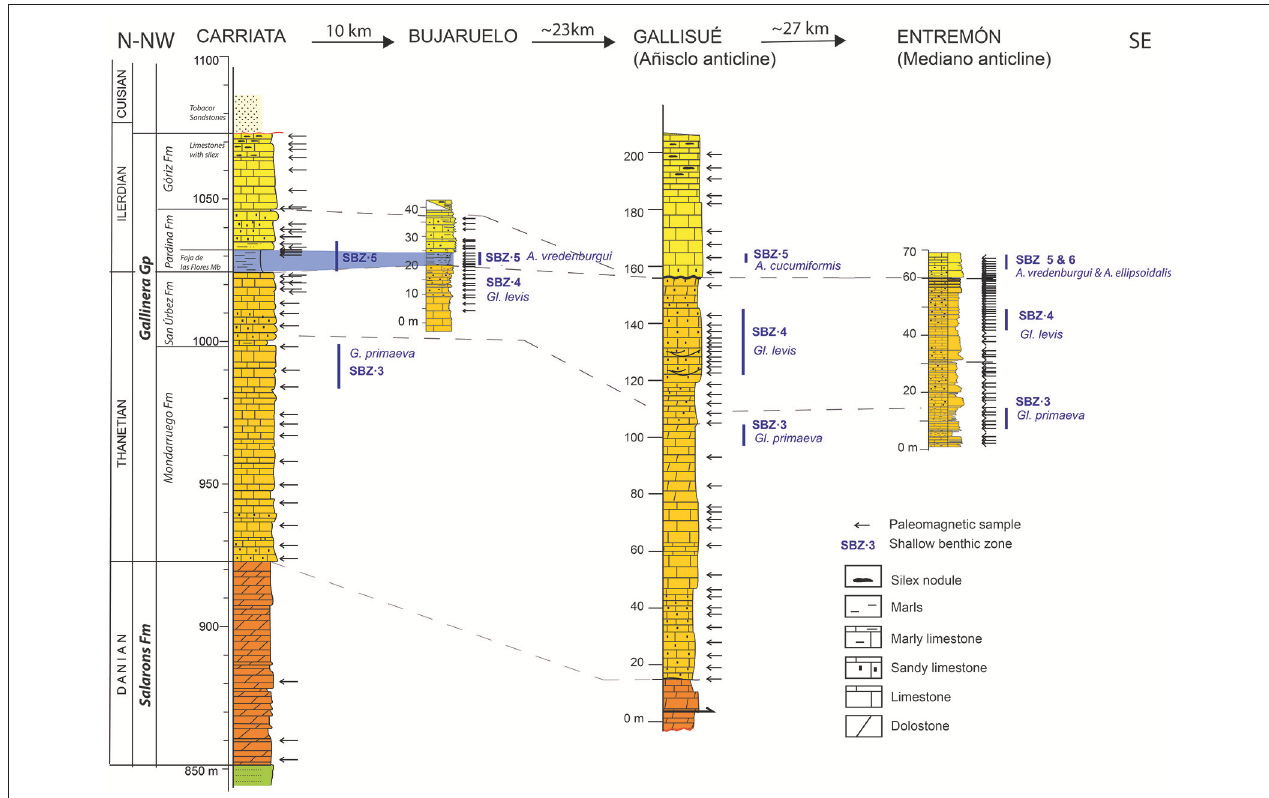
FIGURE 5 | The four sections located from N-NW to SW with distances between each section after simple deformation reconstruction. Age represented on the left. For each column and from left to right, the following are shown: Stratigraphy (Fm names), representation of lithology and age, sampling distances (marked by arrows), and SBZ. The blue thick bar points to the Faja de las Flores Mb (Robador et al., 2010; Pujalte et al., 2016).